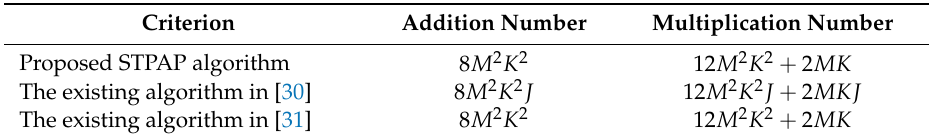
Table 3. Computational complexity.